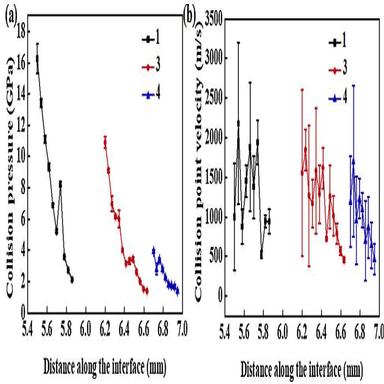
Collision pressure and collision point velocity along the wave interface obtained from Eulerian simulation for type 1, 3 and 4 waves. Error bars represent the standard deviation, where the average and standard deviation of the pressure and velocity are calculated using 9 points from the simulation (the point with max pressure and the surrounding 8 nodes in a quadrilateral mesh).